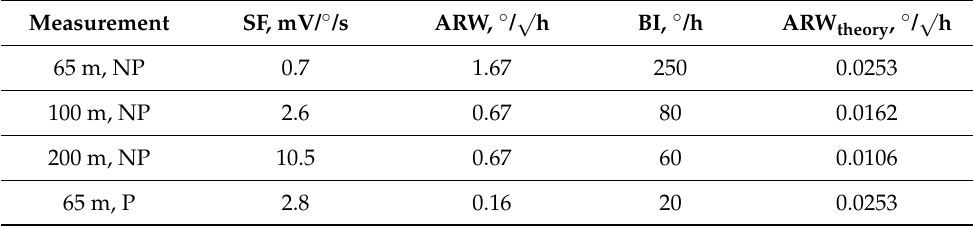
Table 3. Accuracy parameters for each FORR.